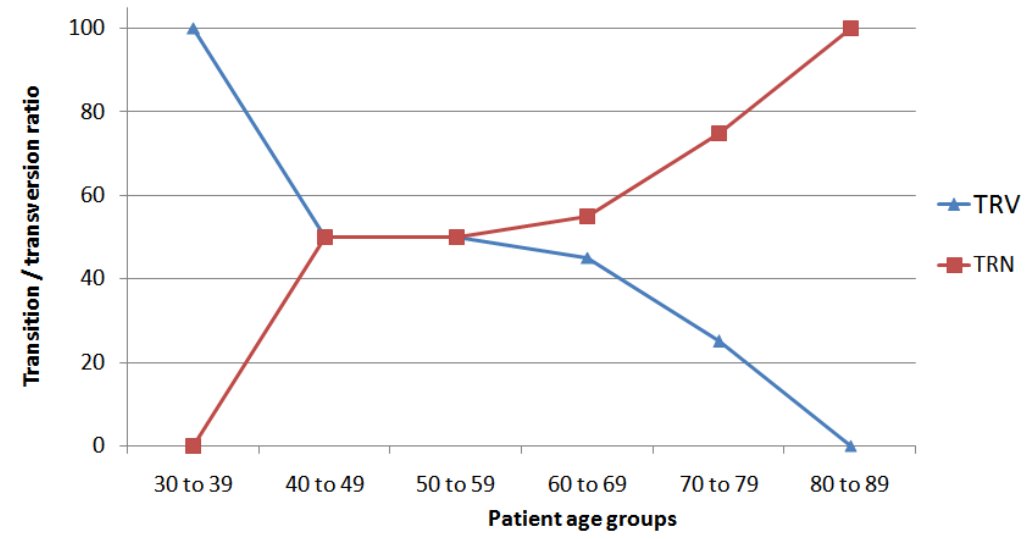
Figure 1. Association of KRAS transition/transversion ratios with age groups in patients with colorectal cancer